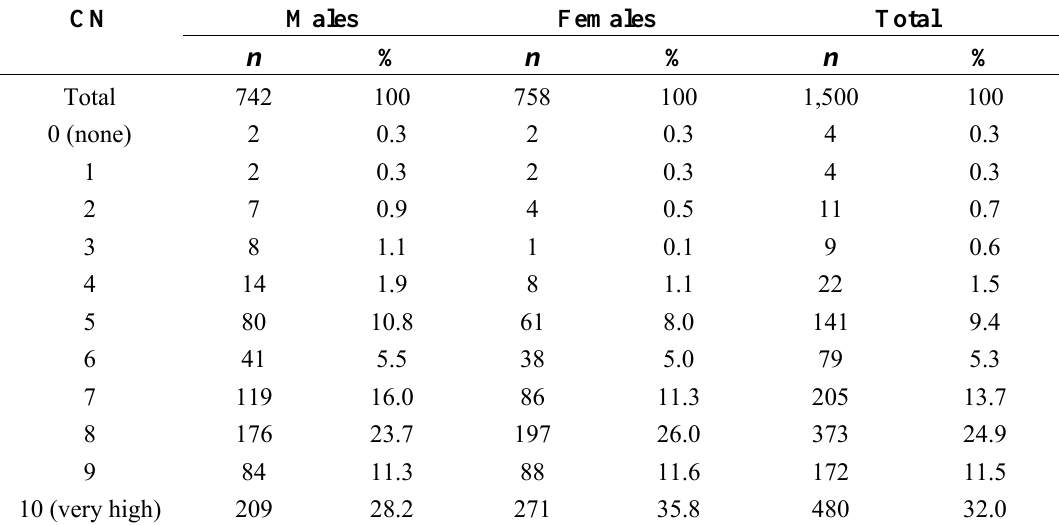
Table 2. Gender-specific distribution of responses to the question “How would you rate your connectedness to nature?” (CN) ranging from “none” (=0) to “very high” (=10).